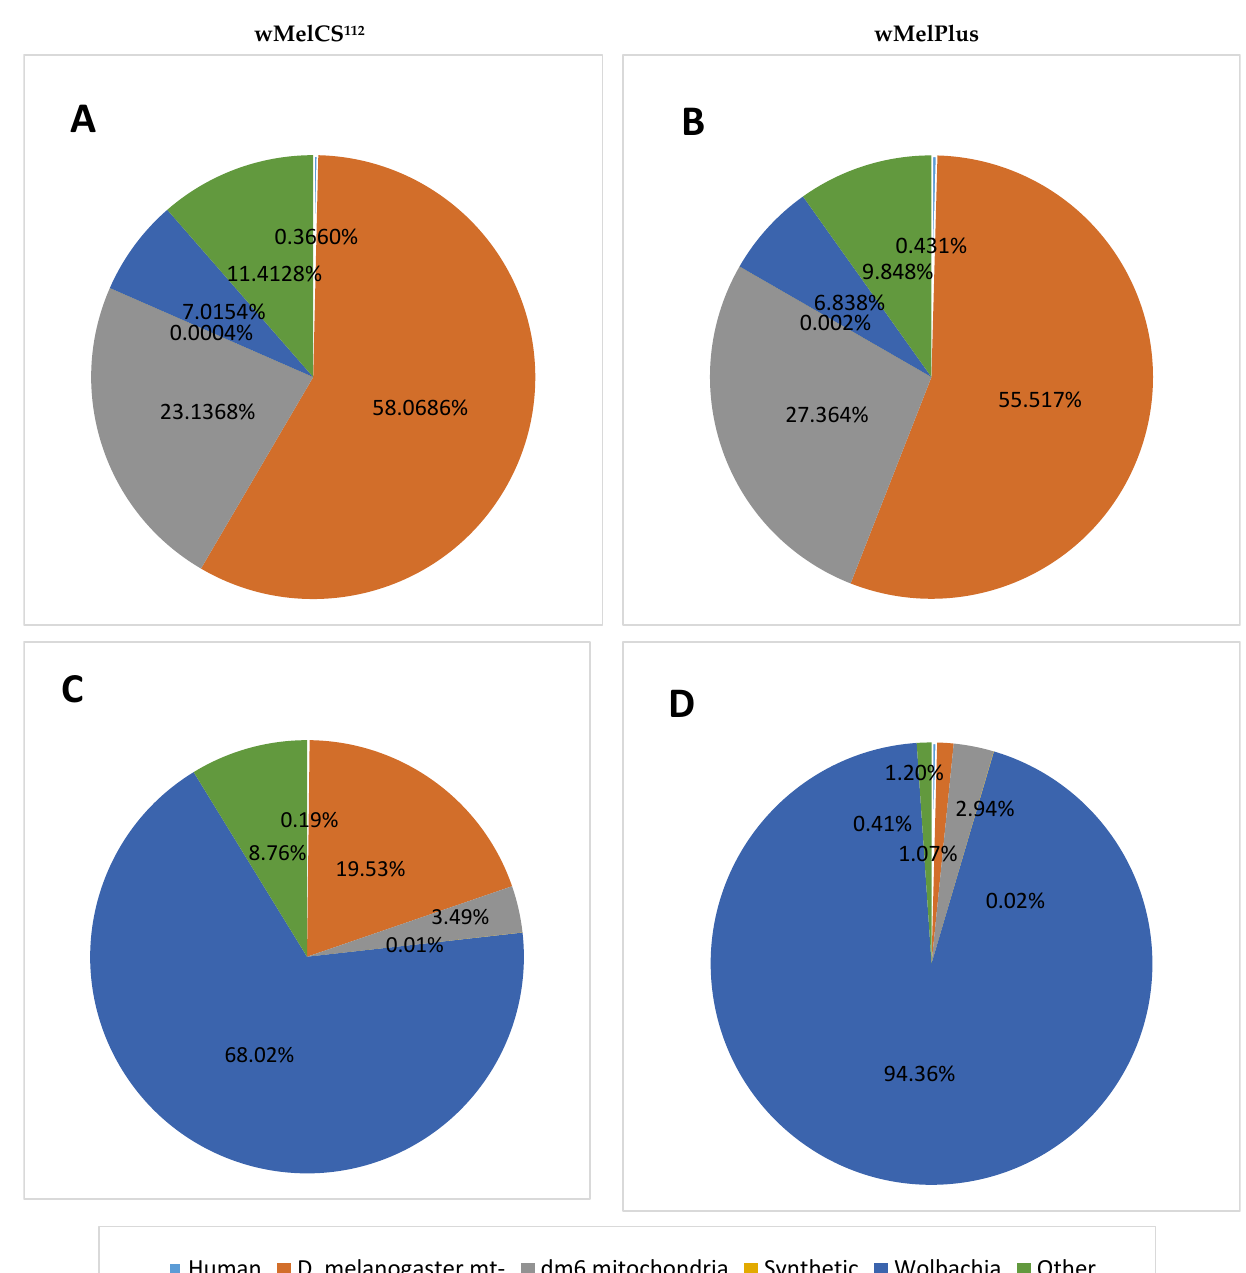
Figure 1. The fractions of reads, belonging to different sources in the four sequenced samples con- taining Wolbachia strains wMelCS 112 ( A , C ) and wMelPlus ( B , D ) extracted from D. melanogaster ova- ries without use of a filter ( A , B ) and from whole females with the use of a filter ( C , D ). Human — hg38 human genome assembly; D. melanogaster mt- — Drosophila dm6 genome assembly, excluding mitochondria; dm6 mitochondria — mitochondrial genome taken from the Drosophila dm6 genome assembly; synthetic — synthetic sequences included in the UniVec database; Wolbachia — Wolbachia wMelCS_b genome assembly; other — the other reads of unknown origin.